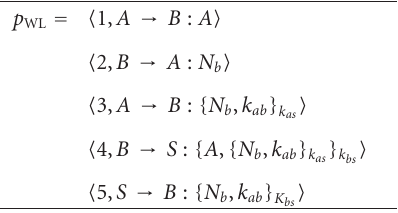
Table 5: Needham schroeder lowe